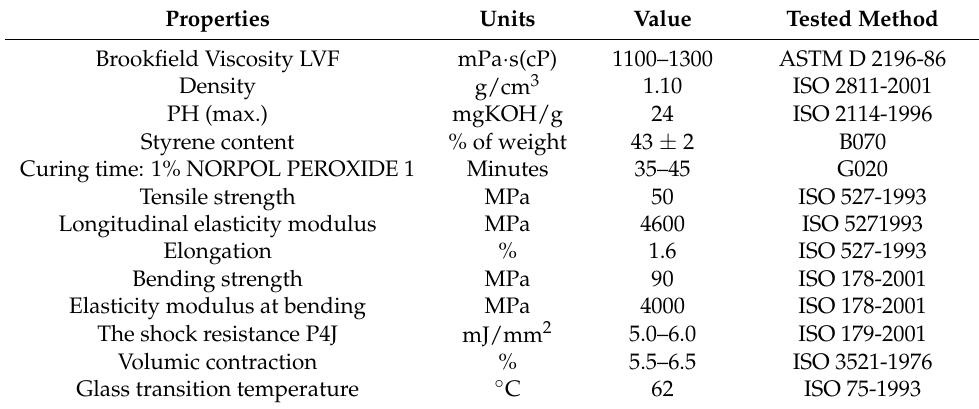
Table 2. Characteristics of polyester resin type 440-M888 POLYLITE at 23 ◦